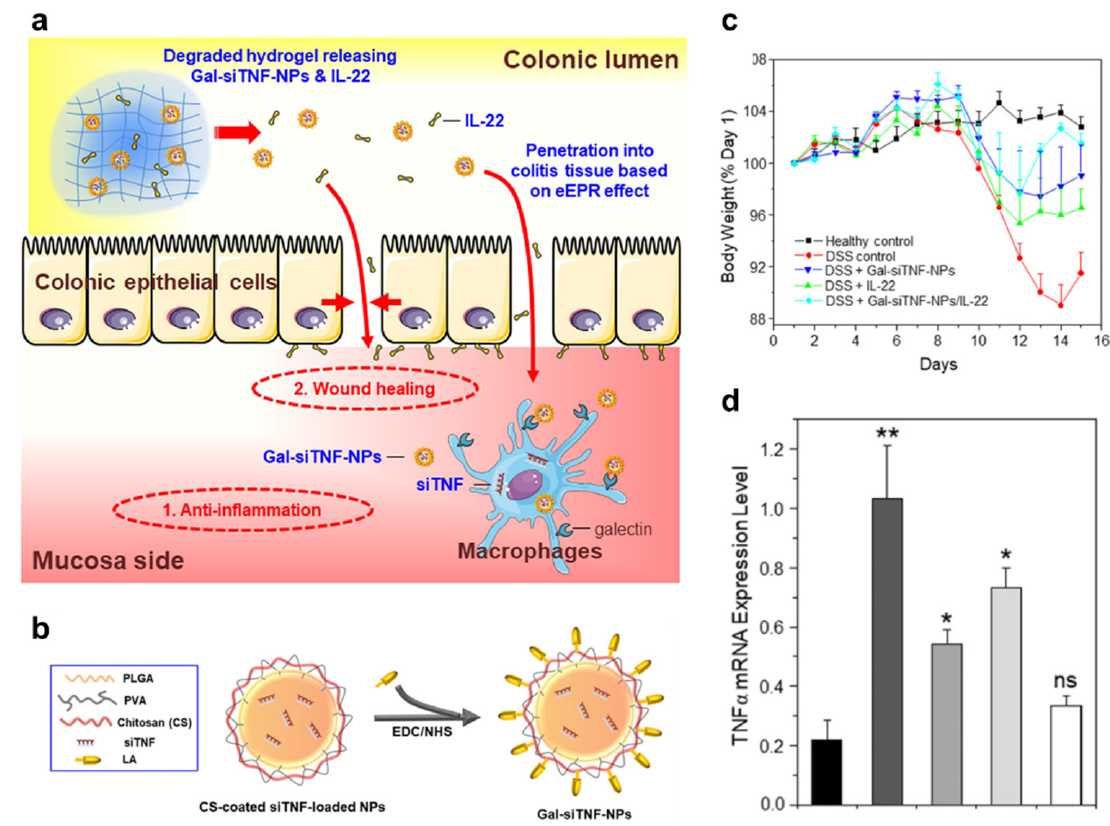
Figure 6. Polymer-based nanoparticles embedded in hydrogels. ( a ): Oral administration of Gal- siTNF-nanoparticles (NP)s plus IL-22 embedded in a hydrogel (chitosan/alginate) shows a much stronger capacity to down-regulate the expression of pro-inflammatory factors and promote muco- sal healing. ( b ): Schematic illustration of the preparation of Gal-siTNF-NPs. ( c ): Mouse body weight over time, normalized as a percentage of day-one body weight. ( d ): TNF- α mRNA expression levels in different mouse treatment groups. Statistical p -values: No significance: ns; * p < 0.05, ** p < 0.01. Reproduced with permission [104]. 2018, Elsevier.